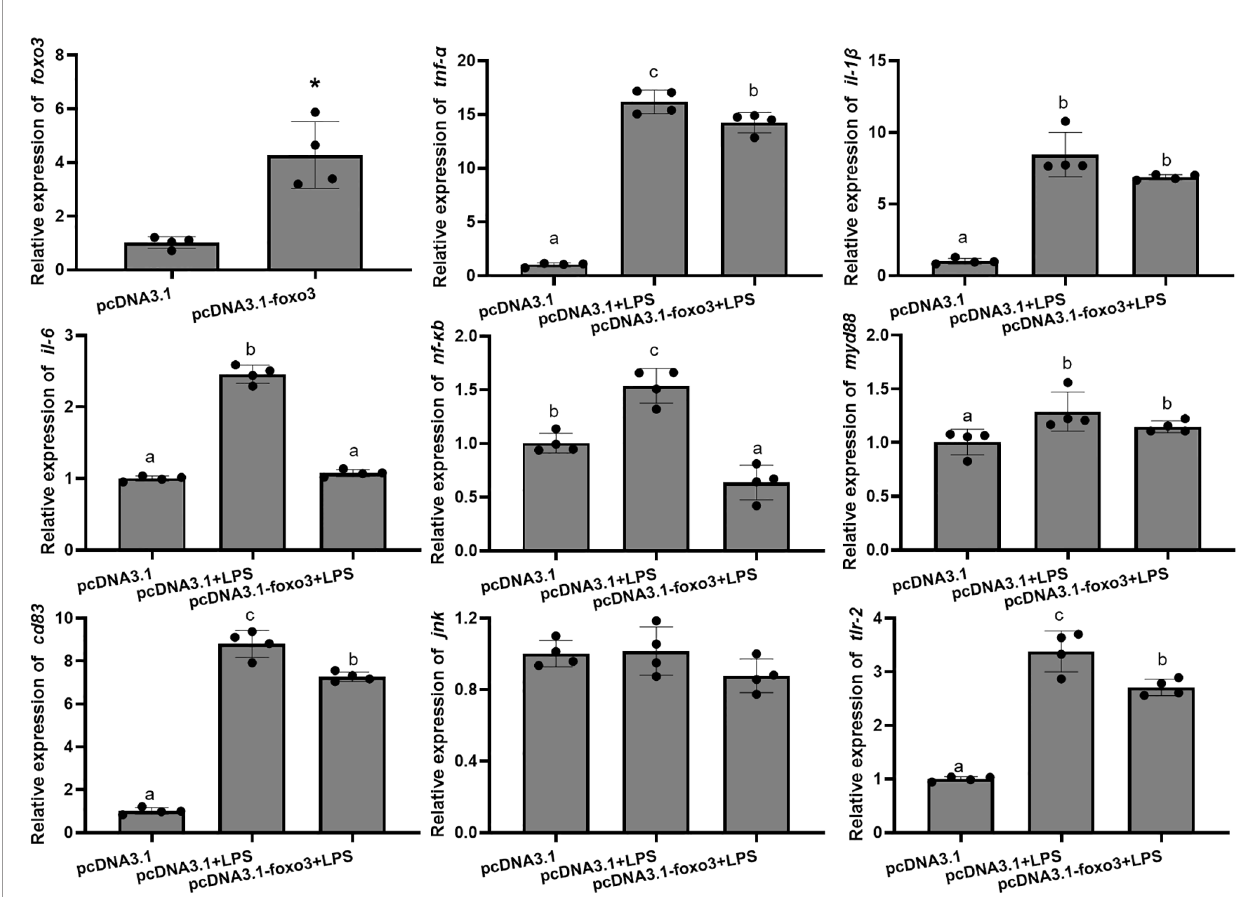
FIGURE 9 | Relative mRNA levels of foxo3 , tnf- a , il-1 b , il-6 , nf- k b , myd88 , cd83 , jnk and tlr-2 in the turbot primary hepatocytes. The results are expressed as the mean ± standard deviation (n = 4). ‘ * ’ means signi fi cantly different between two group ( P < 0.05). The different letters are signi fi cantly different ( P <